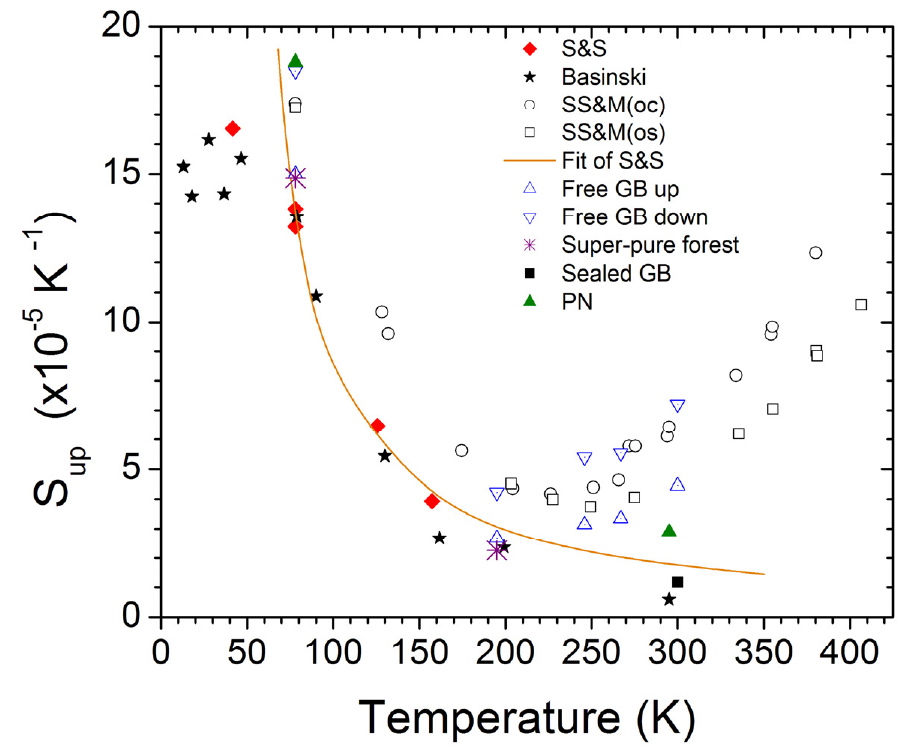
Figure 14. S versus T plot for S up and S down for current super-pure Al and that of PN [47] and free-GB specimens together with those from Al single crystals by Basinski [7] and S&S [11] and prior work on polycrystalline Al by SS&M [46]. Note the change in temperature dependence of S for free-GB after 200 K and the bifurcation between up and down data points.